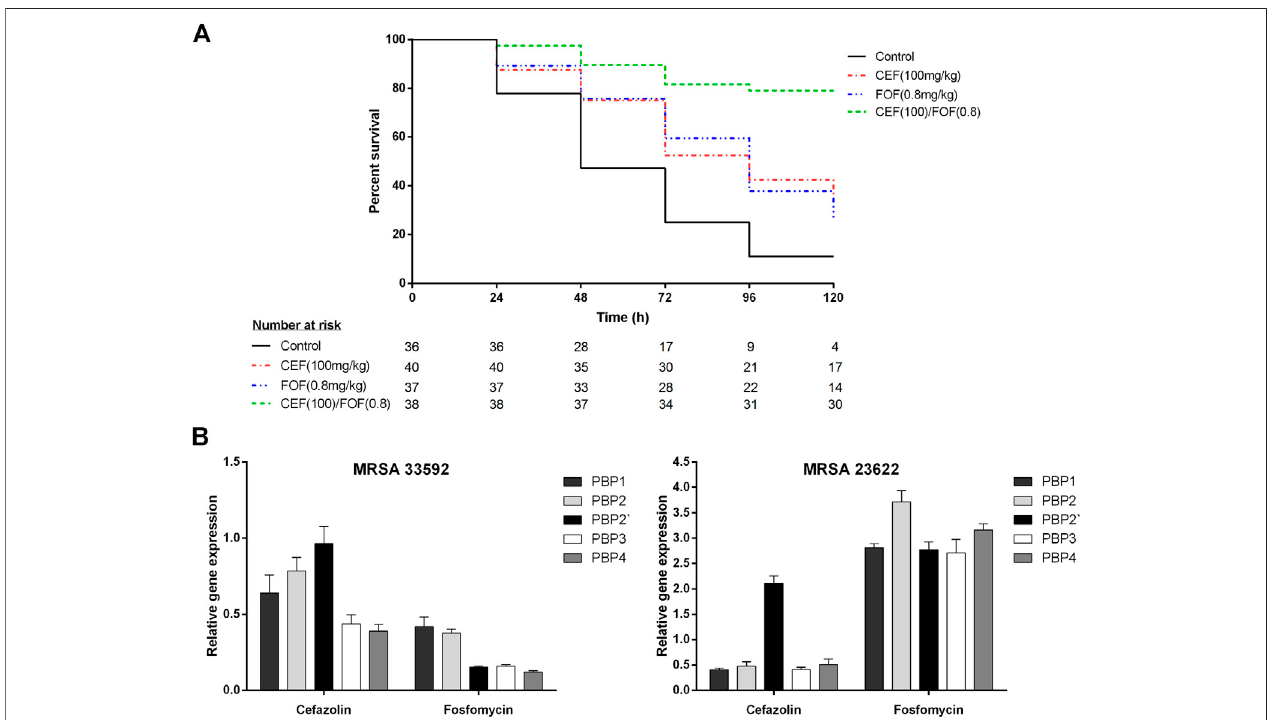
FIGURE1|(A) Survivalcurvesof G.mellonella larvaeinfectedwithmethicillin-resistant Staphylococcusaureus (ATCC-33592) followedbytreatmentwithcefazolin (100 mg/kg),fosfomycin(0.8 mg/kg)orthecombinationofboth(cefazolin100 mg/kgplusfosfomycin0.8 mg/kg).Curvesrepresentthepooleddataoftwoexperiments performed on separate days. (B) Relative gene expression of penicillin binding proteins (PBP1, PBP2, PBP2 ′ , PBP3, and PBP4) determined for one fosfomycin- susceptible (ATCC-33592) and one fosfomycin-resistant (DSMZ-23622) methicillin-resistant Staphylococcus aureus (MRSA) isolate using RT-PCR with gap as housekeeping gene and a no treatment control as reference. Bacteria were exposed to either cefazolin or fosfomycin at a concentration corresponding to 0.25 times of their respective minimum inhibitory concentrations for a time period of 4 h. Data is stated as mean ( ± SD) relative quanti fi cation values. *CEF, cefazolin; FOF,